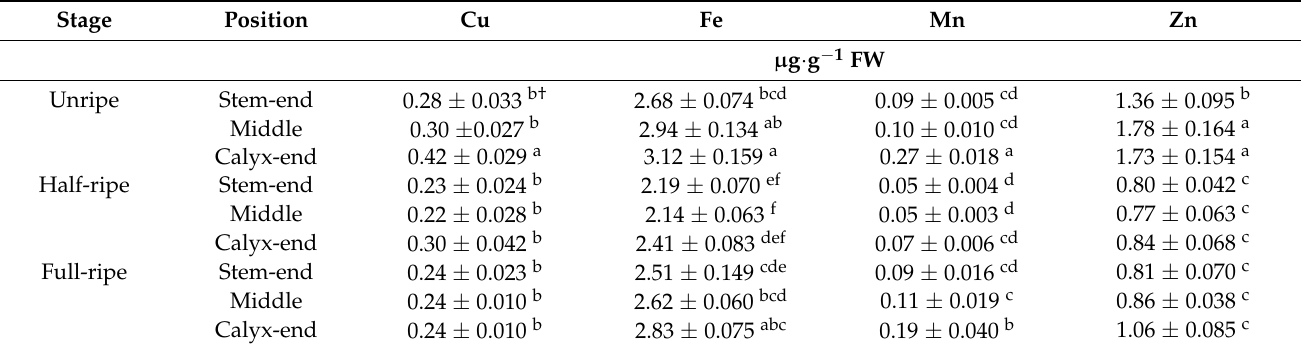
† Different letters within columns indicate significant differences by Duncan’s multiple range